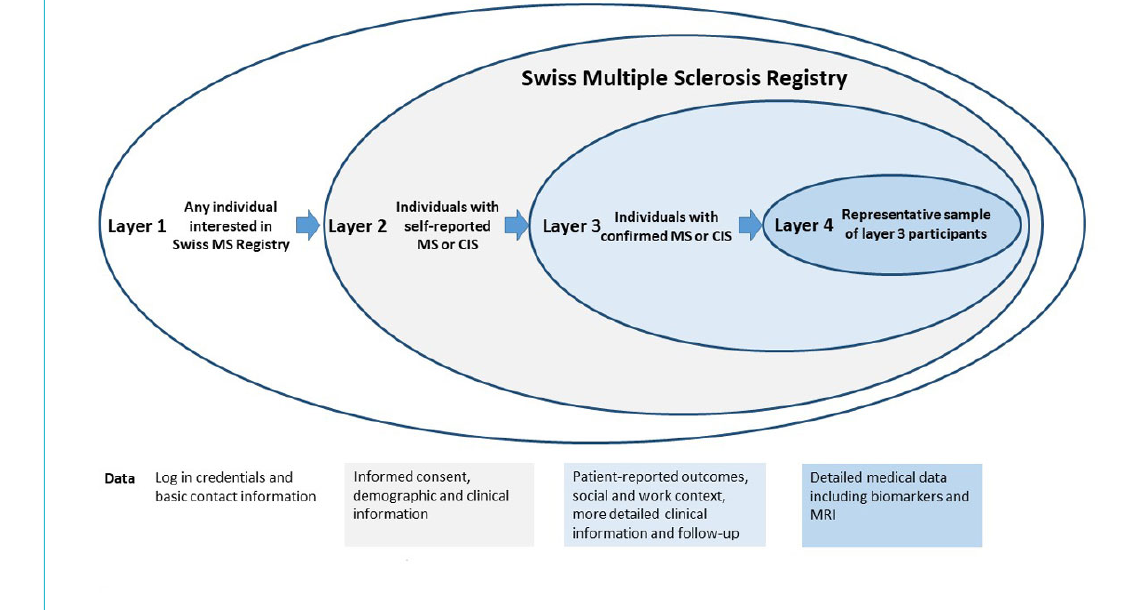
Figure 1: Layered model and type of data collection in the Swiss Multiple Sclerosis Registry.CIS = clinically isolated syndrome; MRI = magnet- ic resonance imaging; MS = multiple